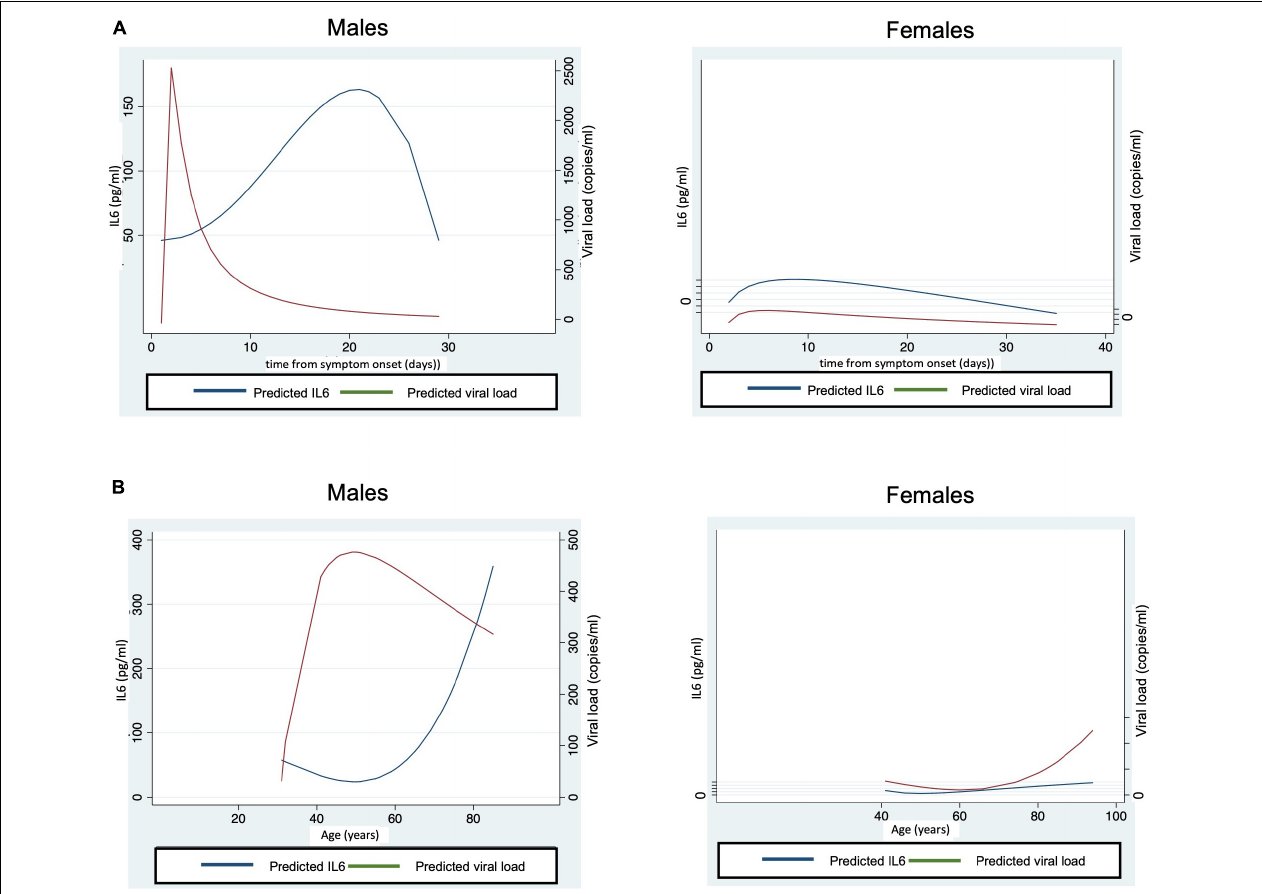
FIGURE 3 | Males had more relevant increases of IL6 and viral load. (A) Represents the levels of IL6 and viral load from symptom onset by sex (both panels using the same scale), while (B) shows levels of IL6 and viral load by age and sex (both panels using the same scale). The fractional polynomial predictions were performed using the twoway command of